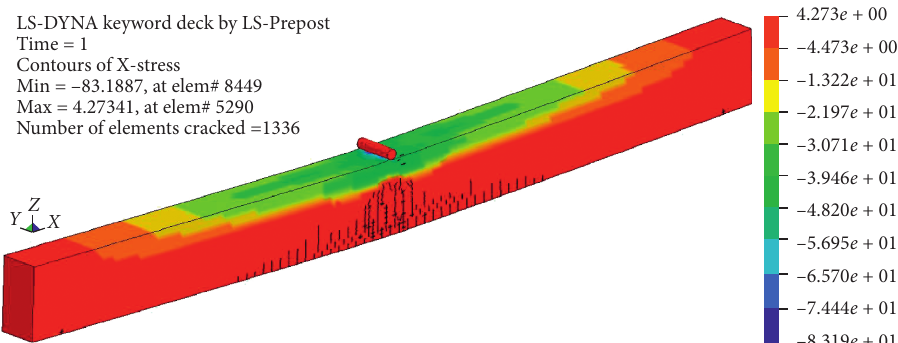
Figure 15: Crack pattern by Winfrith concrete material option at the ultimate loading stage of P � 424kN.